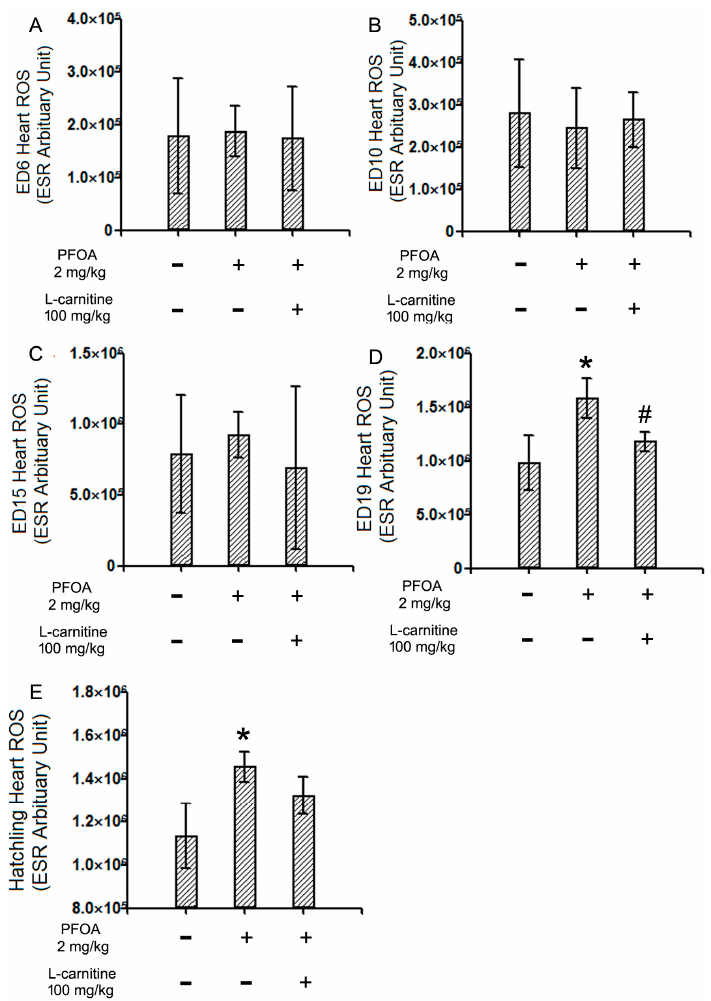
Figure 2. ESRresults of the reactive oxygen species (ROS) levels in ED6, 10, 15, and 19 chicken embryo hearts and hatchling chicken hearts. Fertile chicken eggs were air cell injected with vehicle, PFOA 2 mg/kg, or PFOA 2 mg/kg + L -carnitine 100 mg/kg, and then incubated to ED6, 10, 15, 19, or hatch. At desired stages, hearts were collected and subjected to an electron spin resonance (ESR) assay for ROS. The parameters of ESR were: central field 3480 G, sweep width 250 G, static field 3355 G, microwave bridge frequency 9.86 GHz, power 12.91 mW, step 2 dB. The signal for ROS was read at 3493 G. ( A ) ESR results of ED6 chicken embryo hearts; ( B ) ESR results of ED10 chicken embryo hearts; ( C ) ESR results of ED15 chicken embryo hearts; ( D ) ESR results of ED19 chicken embryo hearts; ( E ) ESR results of hatchling chicken hearts. * Statistically different from control group ( p < 0.05). N = 3–4 per group. # Statistically different from PFOA 2 mg/kg group ( p < 0.05). + Specified treatment is present at the indicated group; − specified treatment is not present at the indicated group. Error bars represent standard derivation (SD).